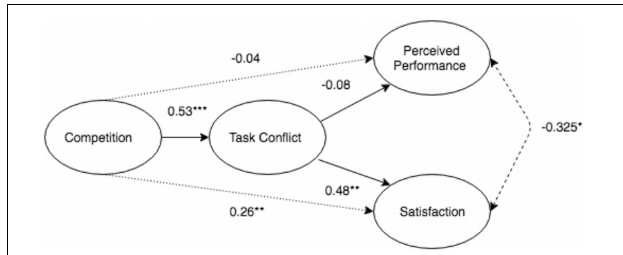
FIGURE 2 | Results of hypothesized model of the direct and indirect effects of competition. Standardized path estimates are reported. The indirect effects are represented by the dotted arrows, while the covariance between outcome variables is represented by the dashed arrow. ∗ p < 0.1, ∗∗ p < 0.05, and ∗∗∗ p <